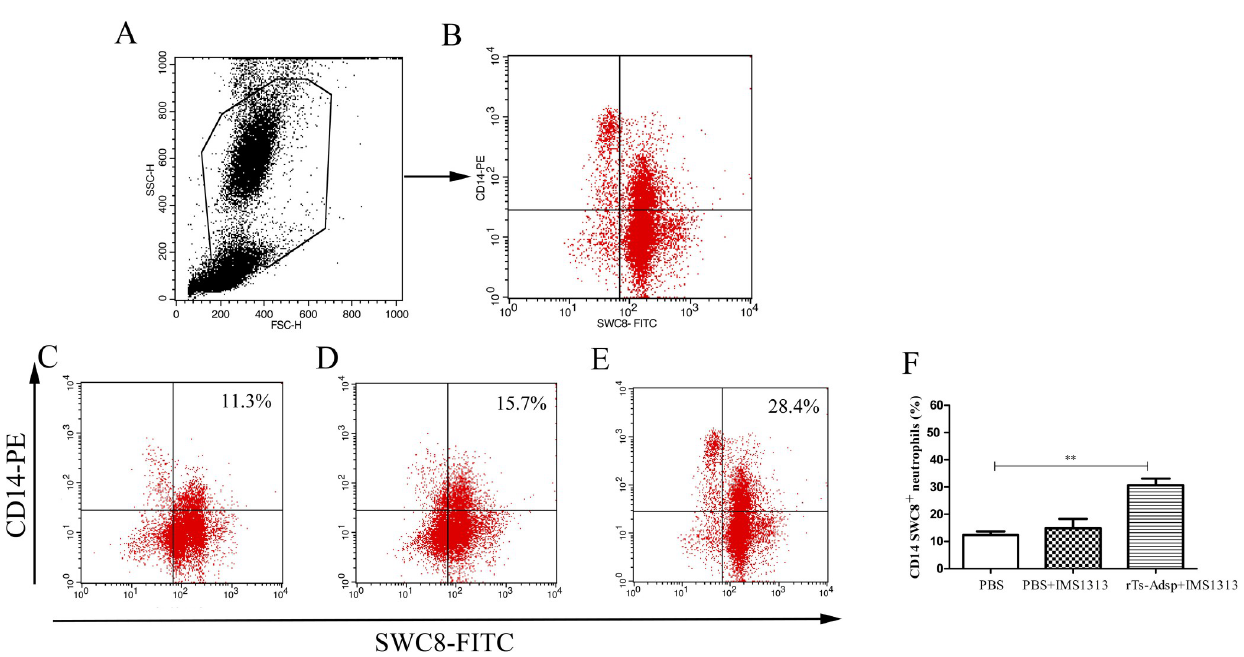
Fig 6. Flow cytometry analysis of neutrophils in peripheral blood. The gating strategy are shown in (A) and (B). The percent change of neutrophils in peripheral blood from (C) PBS-control group (D) IMS1313 adjuvant group (E) rTs-Adsp group. Statistical analysis of (F) the percentage of neutrophils. The values are shown as mean ± SD. Significant differences are as follows: � p < 0.05, �� p < 0.01, ��� p < 0.001.